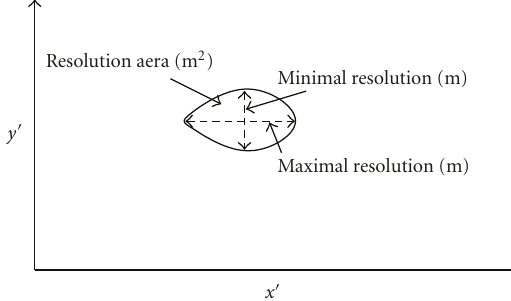
Figure 10: Definition of resolution parameters: maximal and minimal resolution and resolution aera.